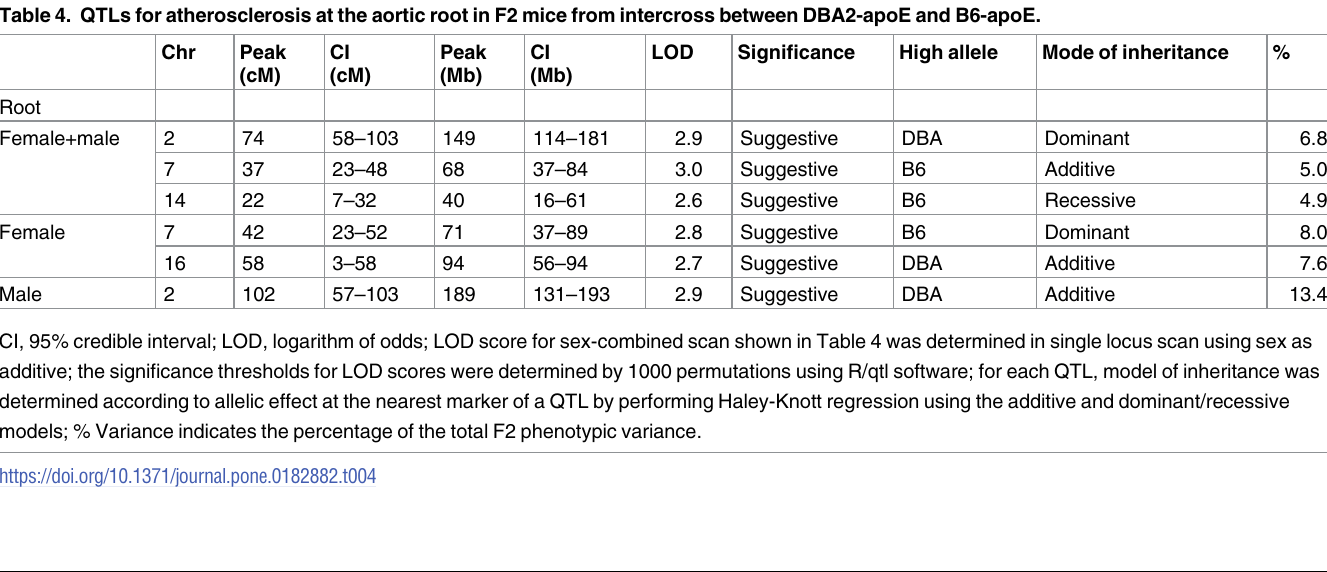
Table 4. QTLs for atherosclerosis at the aortic root in F2 mice from intercross between DBA2-apoE and B6-apoE.